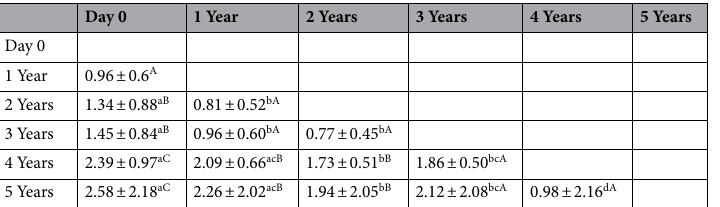
Table 6. The ∆E of the ceramic across 5 years. Lower case letters indicate significant difference within the row ( p < 0.05). Upper case letters indicate significant difference within the column ( p <